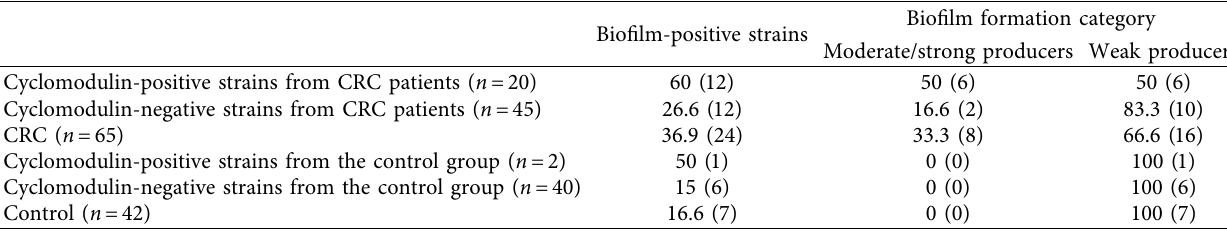
Table 4: Percentage (number) of biofilm-positive isolates and their biofilm formation ability.